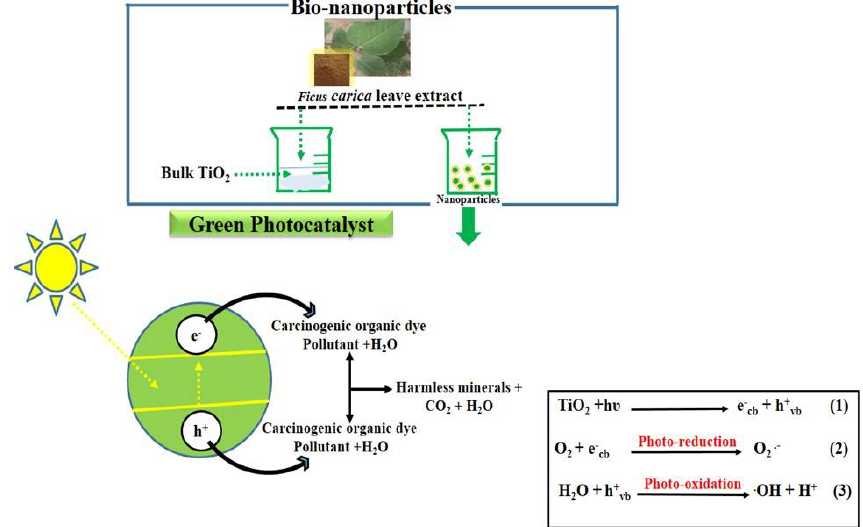
Figure 10. Projected mechanism of photocatalytic degradation of dyes using bulk TiO 2 material treated with various Ficus carica leaf extract of 5, 10, and 15 mL. Figure 10 depicts a proposed mechanism for the breakdown of dye methylene blue when different concentrations of FC leaf extract are mixed with the bulk TiO 2 during exposure to sunlight. As is customary, hazardous organic pollutants are broken down into innocuous byproducts such as (CO 2 , H 2 O) or other organic ions by diverse catalytic pathways in nanostructured materials [38]. The acquired findings were also compared, and the observed performance of the proposed photocatalyst is included in Table 2. The